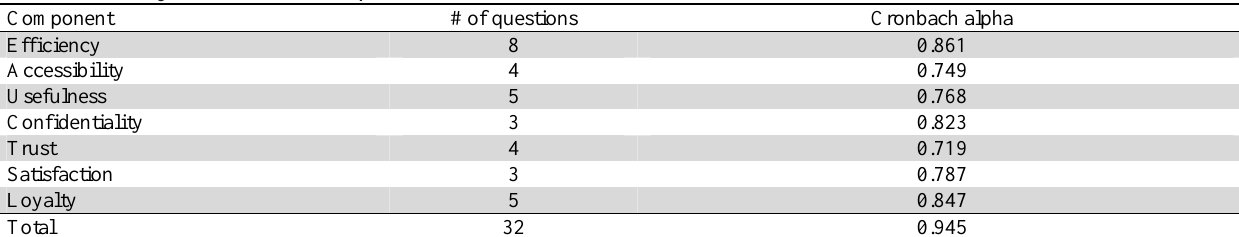
The summary of Cronbach